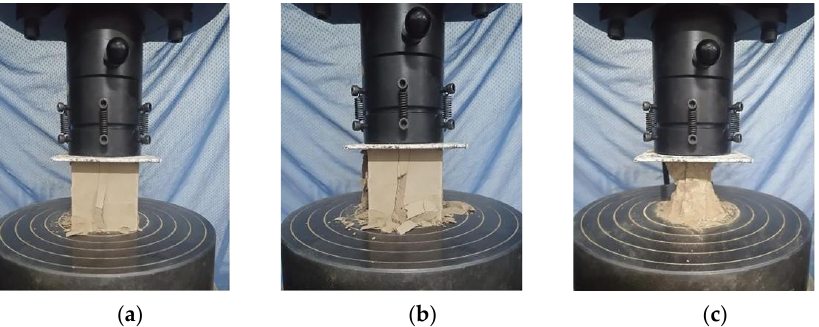
Figure 6. Test typical mode of failure in uniaxial compression for a cubic specimen: ( a ) middle stage of loading; ( b ) load to peak load; and ( c ) failure stage.